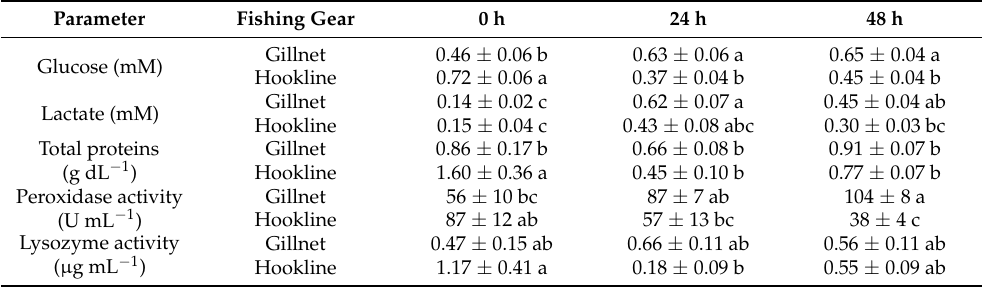
Table 2. Dermal mucus glucose, lactate and total proteins in P. mediterraneus captured by gillnet or hookline. Fish were sampled immediately after capture (0 h) or at times 24 h and 48 h after their introduction into floating sea cages. Data are expressed as mean ± SEM ( n = 8–25 per group and time). Different lowercase letters indicate significantly different groups ( p < 0.05, two-way ANOVA followed by a post hoc Tukey